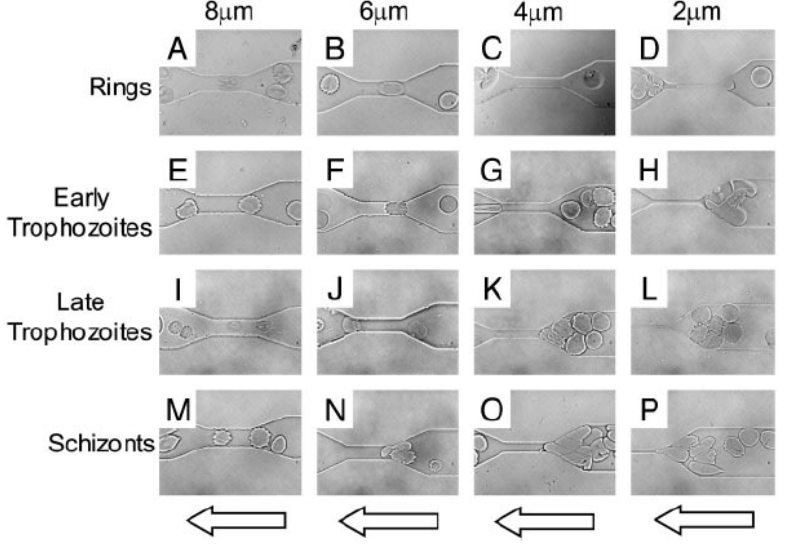
Four sequences of video images taken for the four stages of malaria infected RBCs traversing through the microchannels - ring, early trophozoite, late trophozoite, and schizont stages. (A–D) Ring stage infected RBCs were seen to be able to easily traverse through all microchannels. (E-H) Early trophozoite and (I-L) late trophozoite infected RBCs were able to pass through the 8 and 6 µ m channels (E and F; I and J) but not the 4 and 2 µ m channels (G, H and K, L). Schizont stage infected RBCs could only traverse the 8 µ m channel (M) but not the other channels (N-P). The arrows indicate the flow